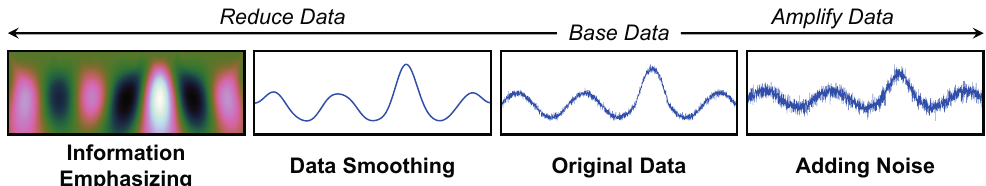
Figure 10. Strategies for Protecting Private Information in Time-Series